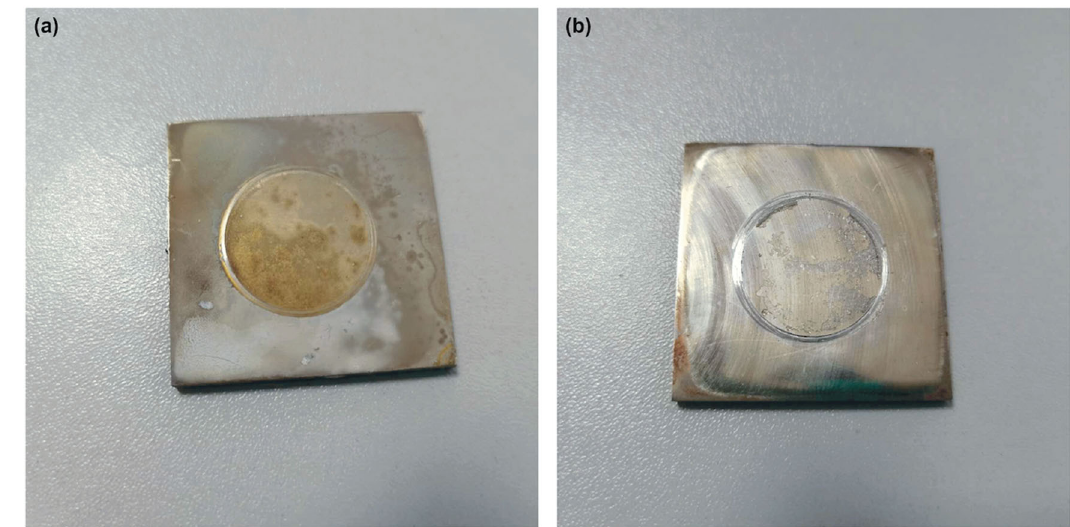
Fig. 10 Macrographs of samples after adhesion strength measurement. a Pristine PDA and chitosan; ( b ) linked-PDA and chitosan